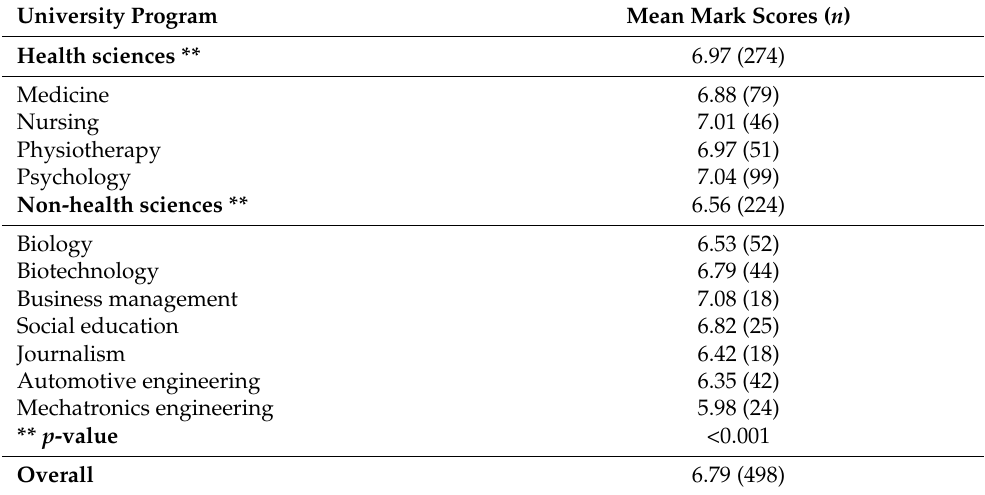
Table 4. Academic performance average ( n = 498). Values are expressed as mean mark scores and number of students in